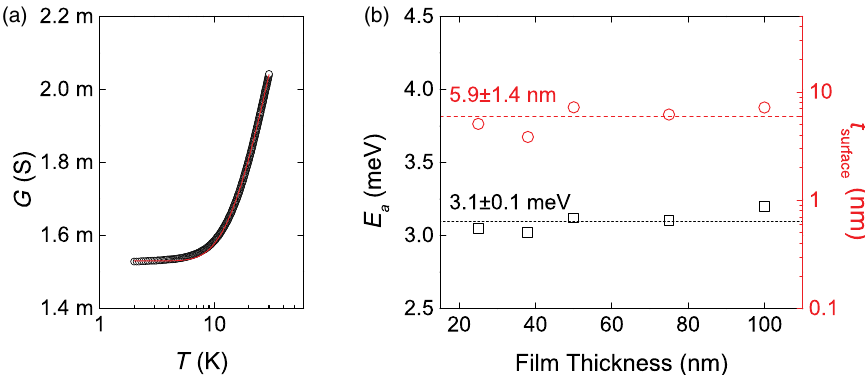
FIG. 2. Estimating the thickness of the surface conduction channel in SmB 6 thin films. (a) Conductance versus temperature of a 25-nm SmB 6 thin film. The red line is a best fit to the experimental data using the parallel conductance model. (b) Activation energy ( E the thickness of the surface conduction channel ( t ) extracted from the fit as a function of the film thickness for SmB 6 surface